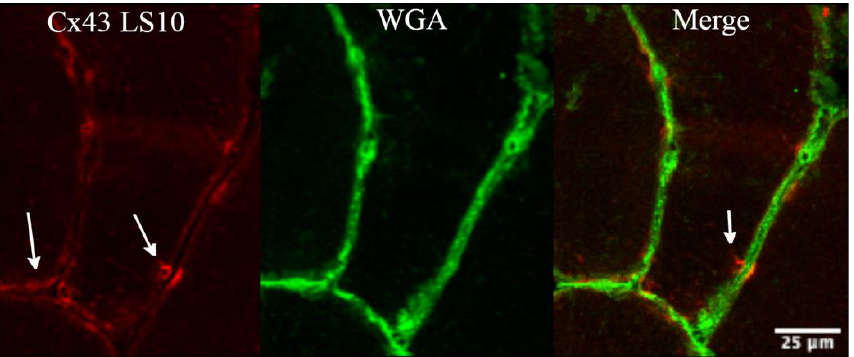
Figure 3. The panel shows detail of the fluorescence signal for Cx43 at higher magnification, obtained along the sarcolemma at 10 days of ULLS. There was no evidence of cluster processes, potentially indicative of gap junction neoformation from fibre to fibre (as indicated by white arrows) with ULLS. Confocal microscope Leica SP5; 20 × zoomed in